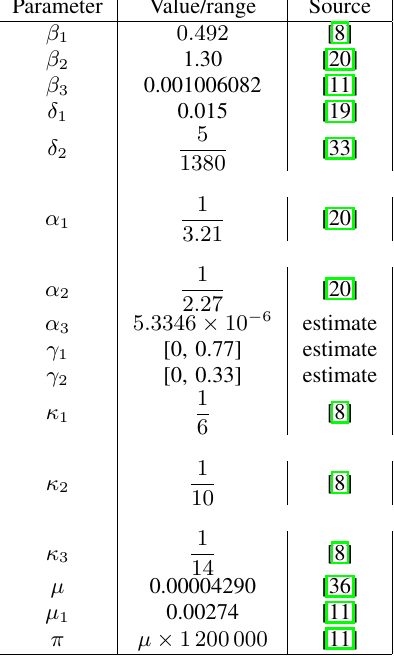
1) Scenario with no lockdown measures: Fig- ure 13 shows that for a fixed rate γ 2 = 0 . 33 of symptomatic infectives, the least rate of isolating asymptomatic infectives should be γ 1 = 0 . 77 for φ = 0 (implying that the population must observe all the prevention measures ,social dis- tancing, mask wearing etc) but that for φ (cid:54) = 0 the hospital bed capacity is never